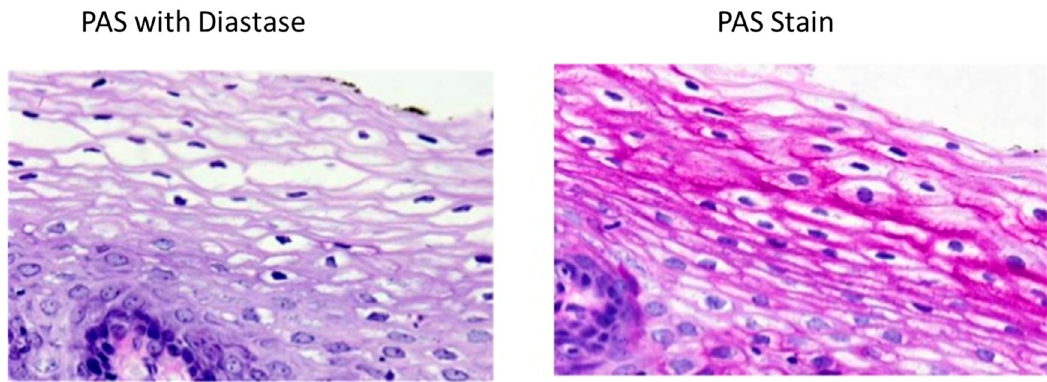
Figure 6. The presence of glycogen is shown by the loss of staining after enzyme treatment when compared to the untreated segments. compared to the untreated